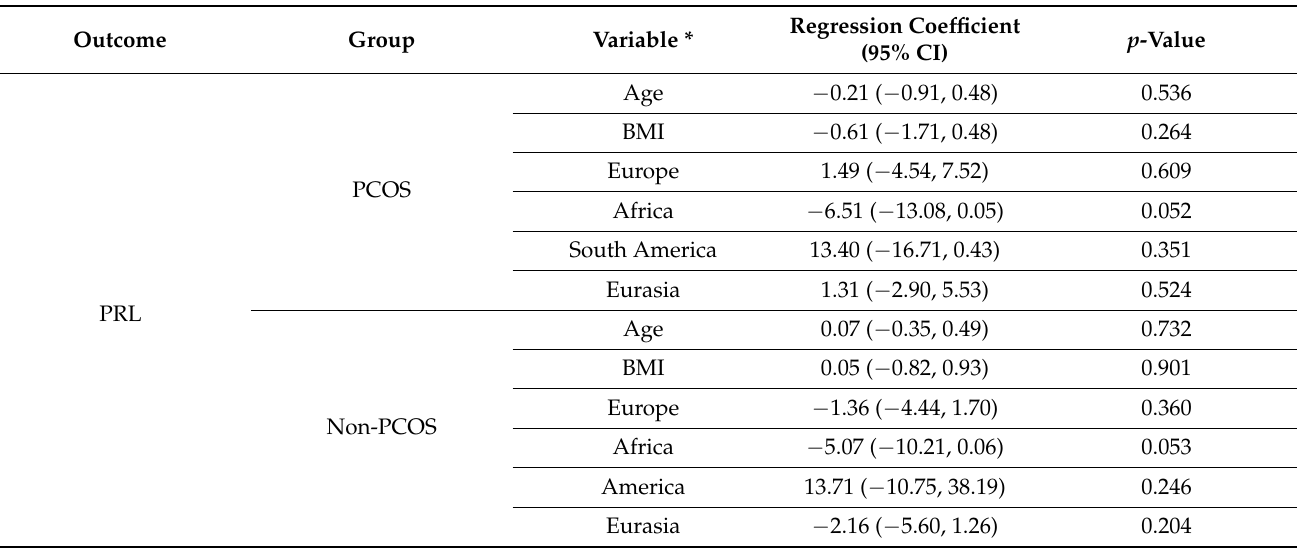
Table 2. The results of meta-regression analysis concerning the effect of confounders on the association between PCOS status on prolactin